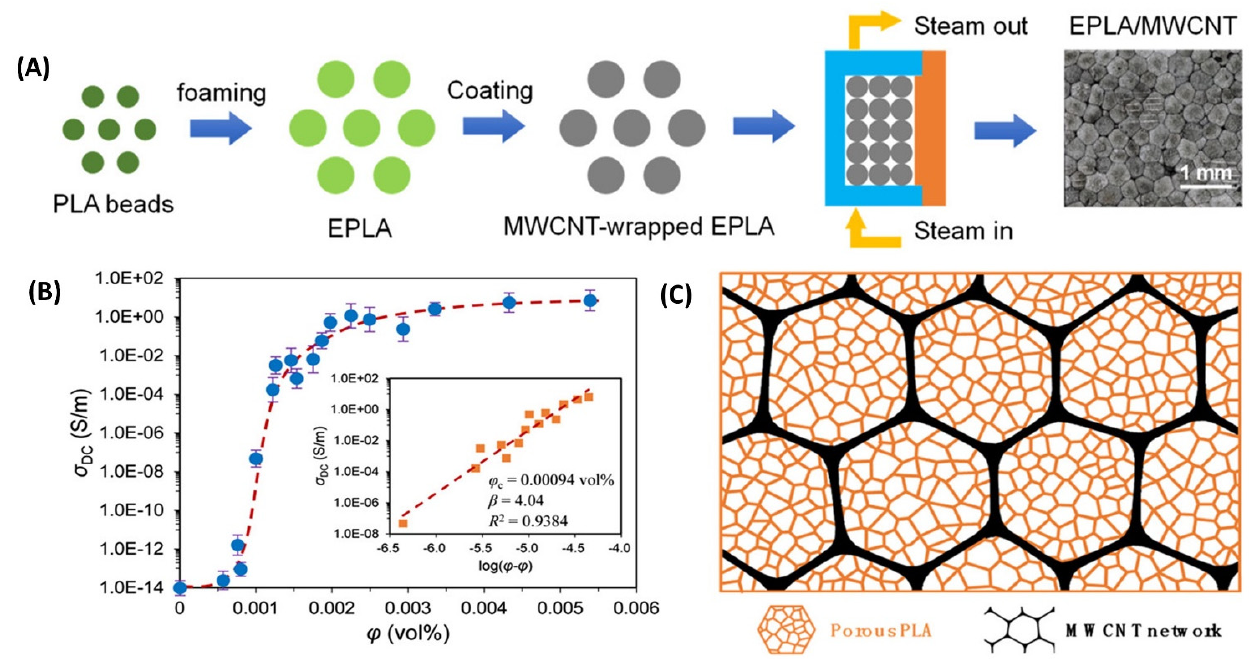
Figure 12. ( A ) Schematic representation of the fabrication technique used to design segregated MWCNT networks in porous PLA/MWCNT foams. ( B ) Variation of the electrical conductivity of these foams with respect to MWCNT content. The inset plot shows σ vs. ( φ − φ c ). ( C ) Schematic illustration of the segregated 3D conductive networks of MWCNTs at the periphery of EPLA beads. Reproduced with permission from [114]. Copyright 2017, American Chemical